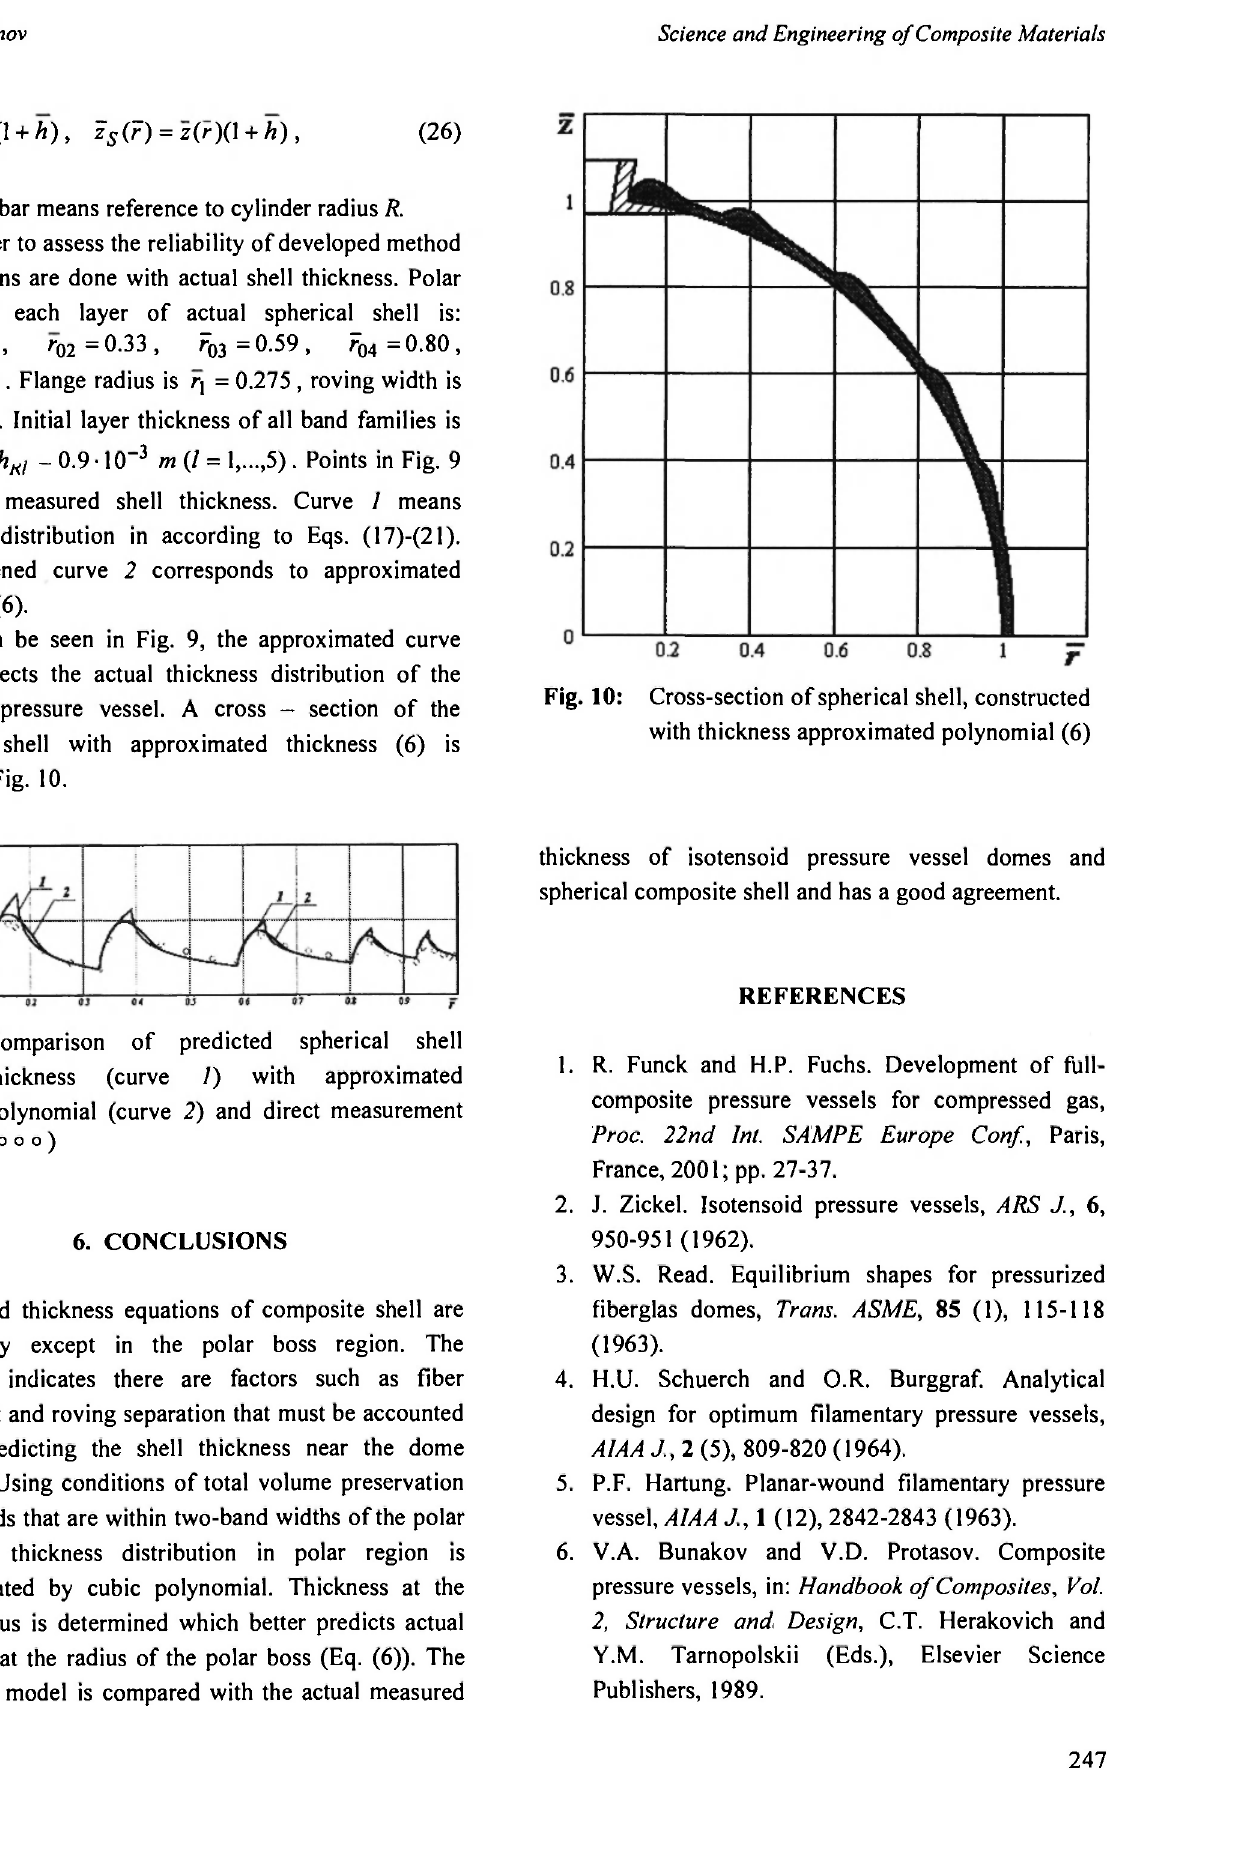
Fig. 9: Comparison of predicted spherical shell thickness (curve 7) with approximated polynomial (curve 2) and direct measurement ( ο ο ο )